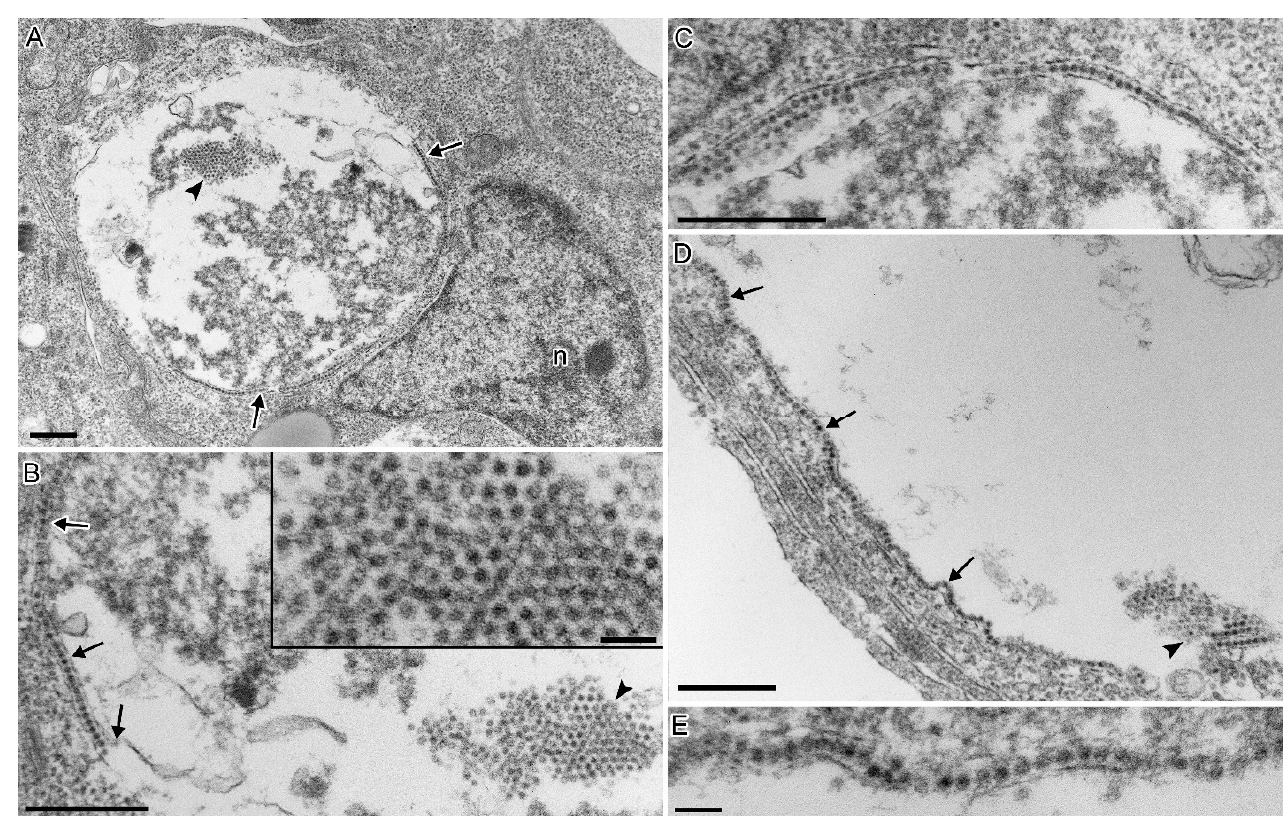
Figure 4. CHSE-214 cells infected with CTV-2. ( A ) A cell with severely dilated ER, making a vacuolar space containing replicating virus. Endoplasmic reticulum (ER) containing viral capsids delimits the vacuole (arrows) and viral capsids are arranged in a crystal array within the vacuole lumen (arrowheads). (n, nucleus) (bar = 500 nm). ( B ) Higher magnification from ( A ) showing viral capsids in a single row within the ER lumen (arrows). Note the inner ER membrane opens to the dilated ER lumen making up the vacuolar space (bottom arrow). Viral capsids arranged in a crystal array (arrowhead and inset) (bar = 500 nm; inset bar = 100 nm). ( C ) Host cell ER, containing one to several rows of viral capsids within the lumen. The ER delimits the host cell cytoplasm (top of image) from the dilated ER lumen containing electron-dense viral proteins (bottom of image) (bar = 500 nm). ( D ) Another infected cell with virions in a single row within the lumen of the ER (arrows) delimiting the host cell cytoplasm and dilated ER lumen containing virions; viral accumulation in a crystal array pattern (arrowhead) (bar = 500 nm). ( E ) Higher magnification from ( D ) showing virions within the lumen of the ER (bar = 100 nm).